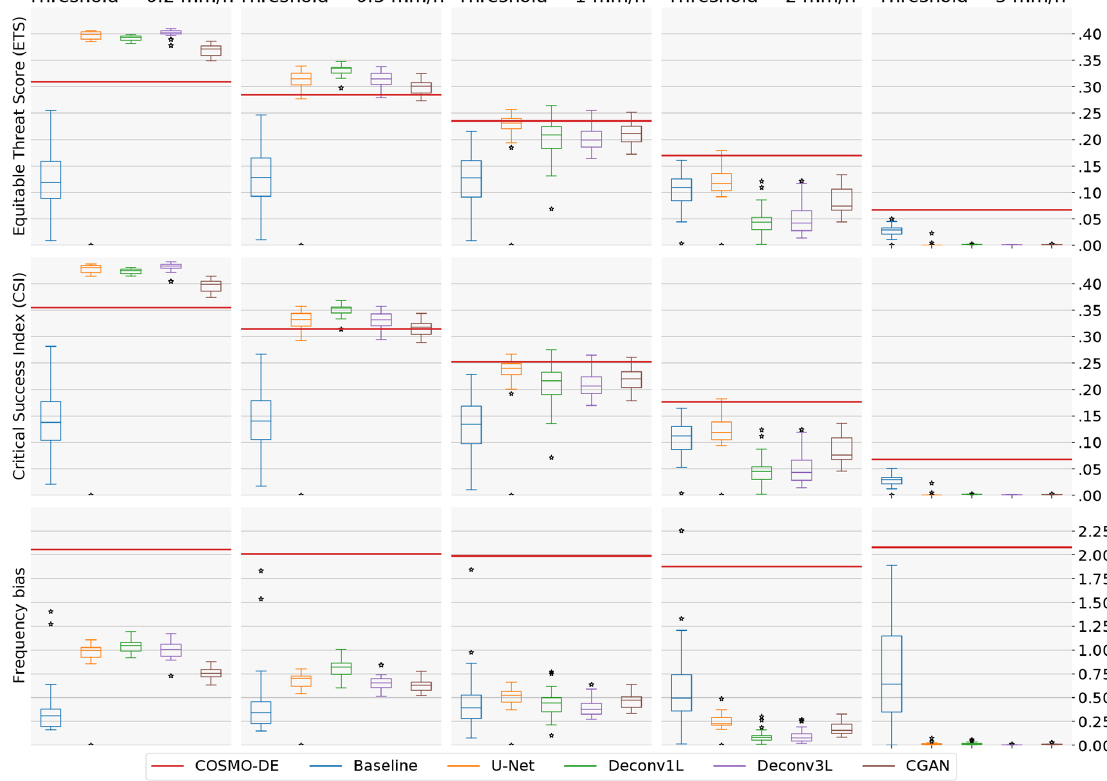
Figure 5. Dichotomous metrics: each subplot illustrates the metrics score of 20 independent models with different initial conditions after a certain threshold was applied. The ETS and CSI vary between 0 and 1, with 0 indicating no skill and 1 a perfect forecast. Frequency bias ranges from 0 to +∞ , with bias < 1 indicating under-forecasting, bias > 1 indicating over-forecasting and a perfect score =